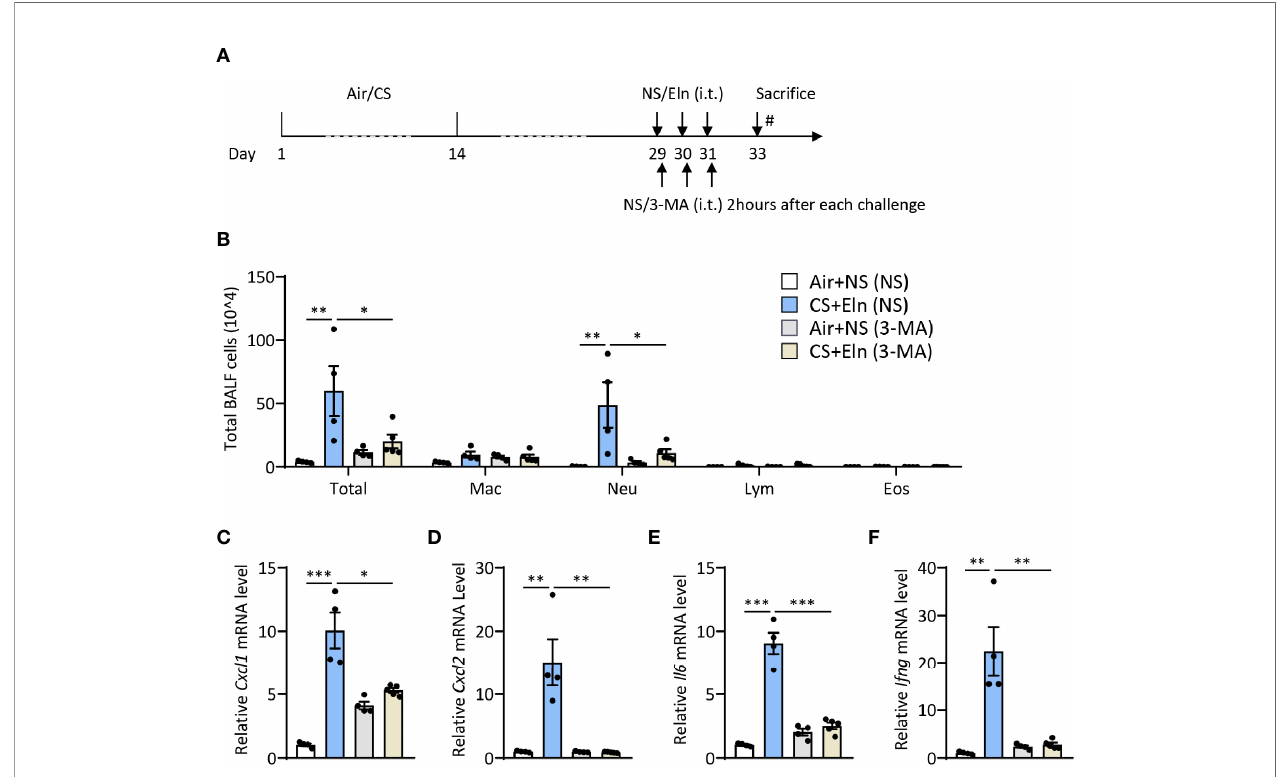
FIGURE 3 | Inhibition of autophagy during elastin challenge alleviates the neutrophilic airway in fl ammation in vivo . (A) Experimental outline and protocol for 3-MA treatment, 3-MA (4 mg/ml, 50 m l) was administrated intratracheally 2 hrs after each elastin peptide (2 mg/ml, 50 m l) challenge. (B) In fl ammatory cell counts in the BALF. (C – F) The Cxcl1 , Cxcl2 , Il6 and Ifng mRNA transcripts in lungs. Labeling for all the columns throughout Figure 3 was shown in (B) . Mac, macrophages; Neu, neutrophils; Lym, lymphocytes; Eos, eosinophils. Throughout, data are representative of 4-5 mice and were replicated in at least 3 independent experiments. Data are presented as mean ± s.e.m. * p < 0.05, ** p < 0.01, *** p < 0.001 by one-way